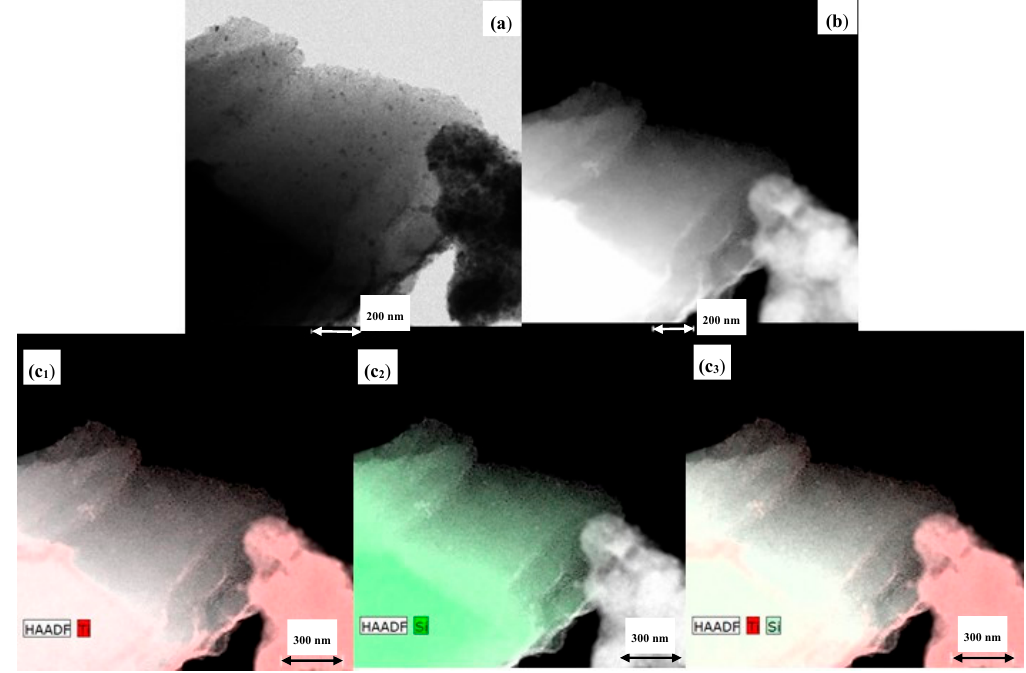
Figure 3. ( a ) Transmission electron microscopy (TEM), ( b ) scanning transmission electron microscopy (STEM) and ( c i ) mapping results of the Ti-SBA support.